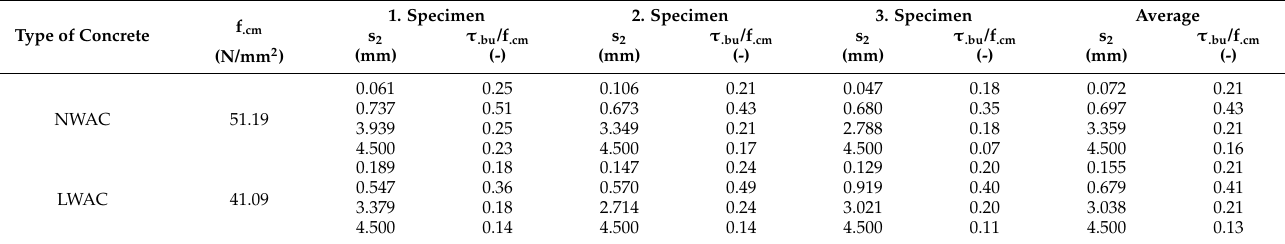
Table 8. Bond strength and slip of NWAC and LWAC.